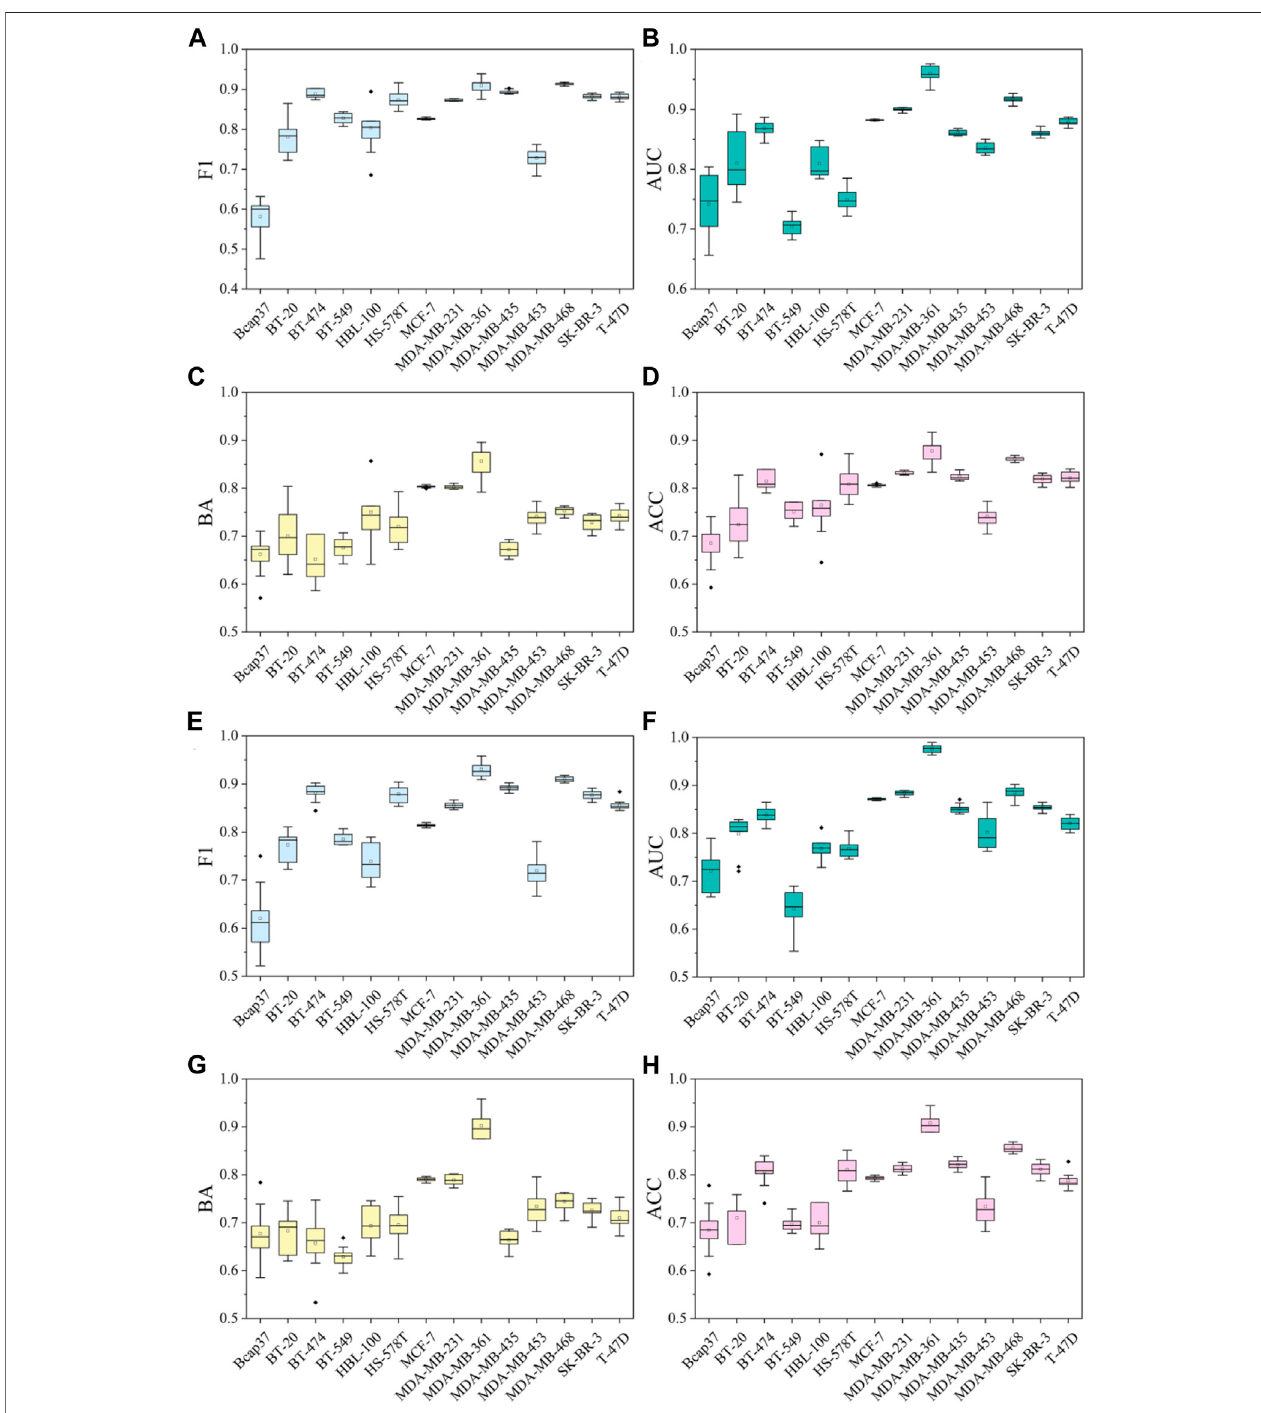
FIGURE 7 | The performance of 10-fold cross-validation results in RF:Morgan and XGBoost:Morgan models. (A – D) F1 scores, AUC, BA, and ACC results in RF: Morgan models. (E – H) F1 scores, AUC, BA, and ACC results in XGBoost:Morgan models.